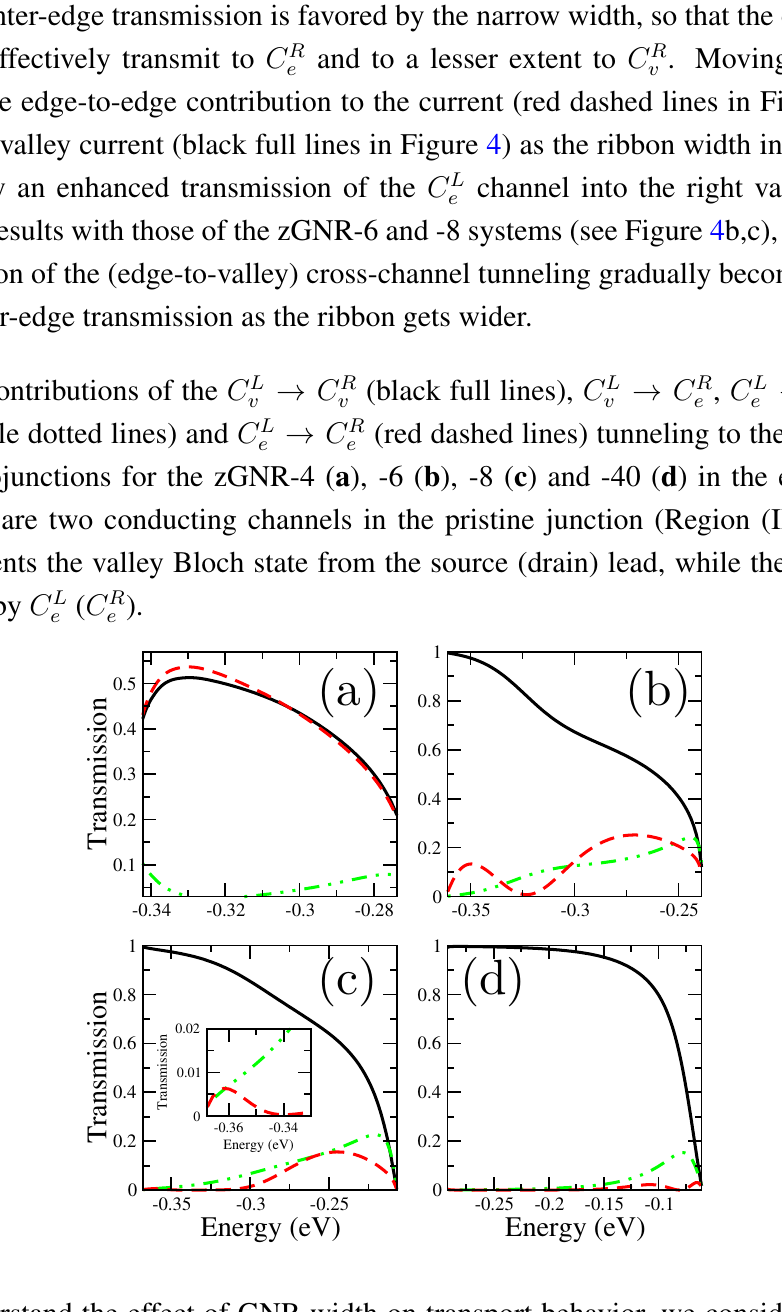
→ C R → C R , C L (green v e e v